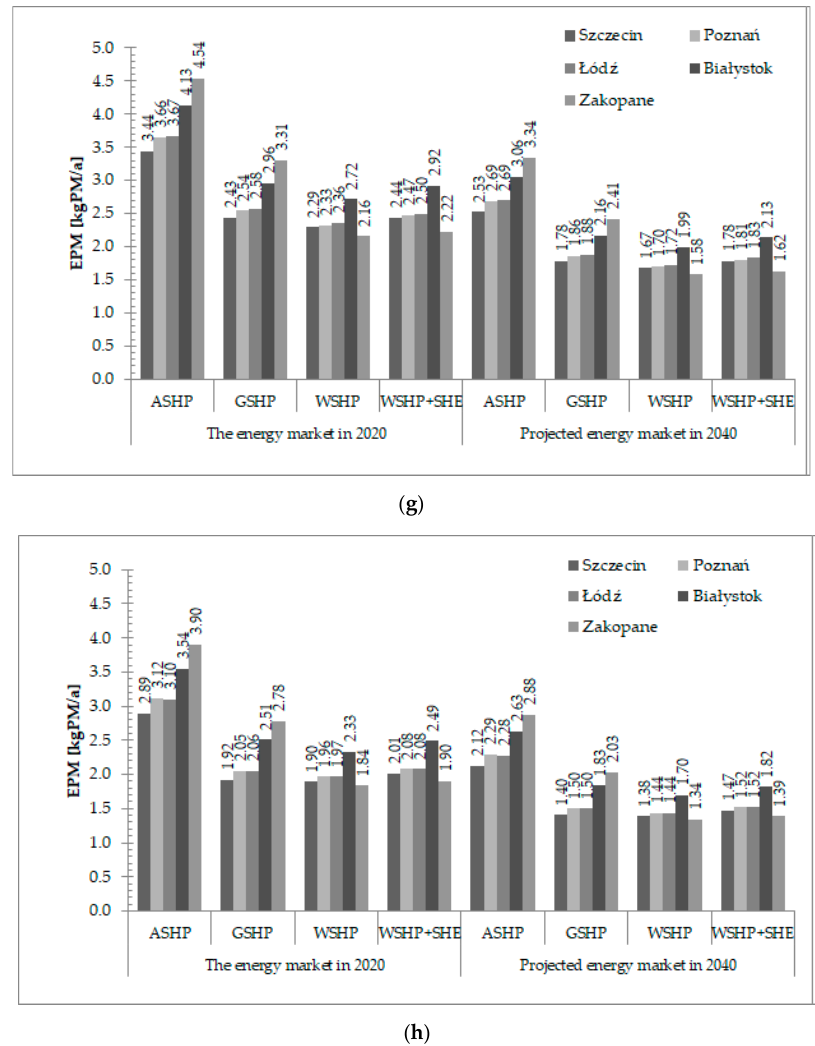
Figure 2. Greenhouse gases and particulate matter emissions for specific locations: ( a ) carbon diox- ide emissions at a constant temperature in the buffer tank; ( b ) carbon dioxide emissions with changed temperature in the buffer tank; ( c ) sulfur dioxide emissions at a constant temperature in the buffer tank; ( d ) sulfur dioxide emissions with changed temperature in the buffer tank; ( e ) nitro- gen oxide emissions at a constant temperature in the buffer tank; ( f ) nitrogen oxide emissions with changed temperature in the buffer tank; ( g ) PM emissions at a constant temperature in the buffer tank; ( h ) PM emissions with changed temperature in the buffer